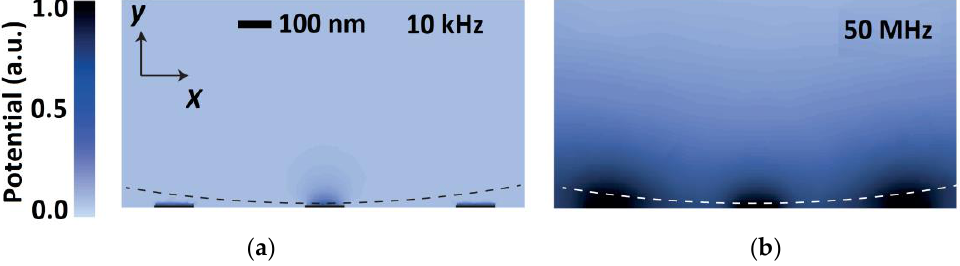
Figure 7. Spatial distribution of AC potential in 10 mM salt solution at ( a ) low modulation frequency of 10 kHz and ( b ) high modulation frequency of 50 MHz. Adapted with permission from [73], Copyright 2015 Springer Nature.